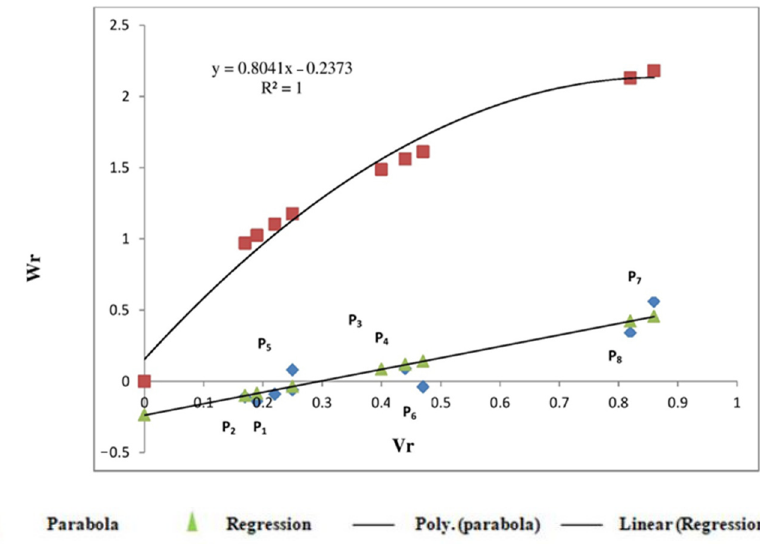
Figure 1. Wr–Vr graph for protein content in E 1 . P1 = GW 451; P2 = GW 496; P3 = LOK 1; P4 = GW 322; P5 = GW 366; P6 = HI 1544; P7 = GW 173; P8 = GW 11; P9 = HD 2864; P10 = UAS 385. The regression line Y = 0.8941 x − 0.3358 (Figure 2) intercepted the Wr axis below the origin, indicating an overdominant gene action in E 3 . The array point of GW 322 and GW 496 was the nearest to the origin; thus, it likely contributed to the overdominant genes.